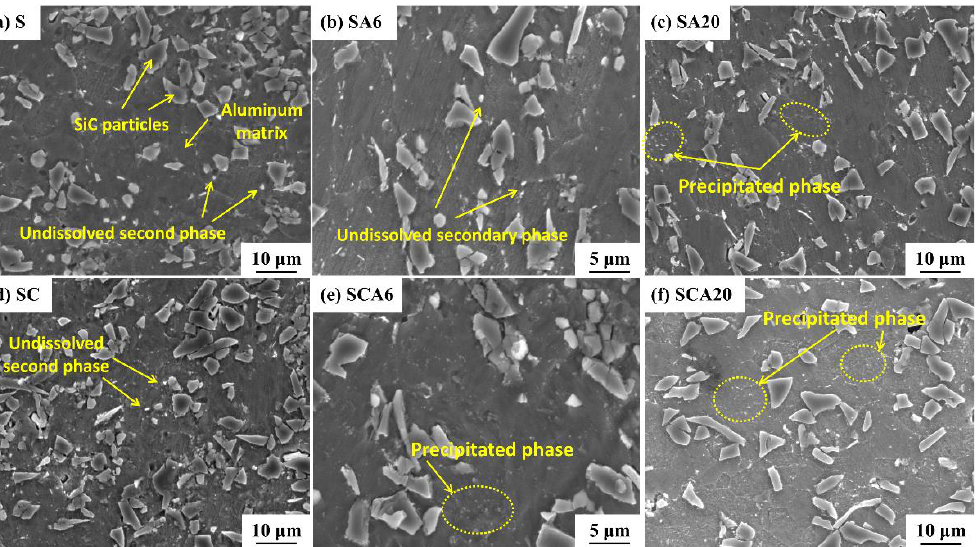
Figure 9. SEM micrographs of SiCp/2009Al composites treated by different processes: ( a ) S; ( b ) SA6; ( c ) SA20; ( d ) SC; ( e ) SCA6; and ( f ) SCA20.